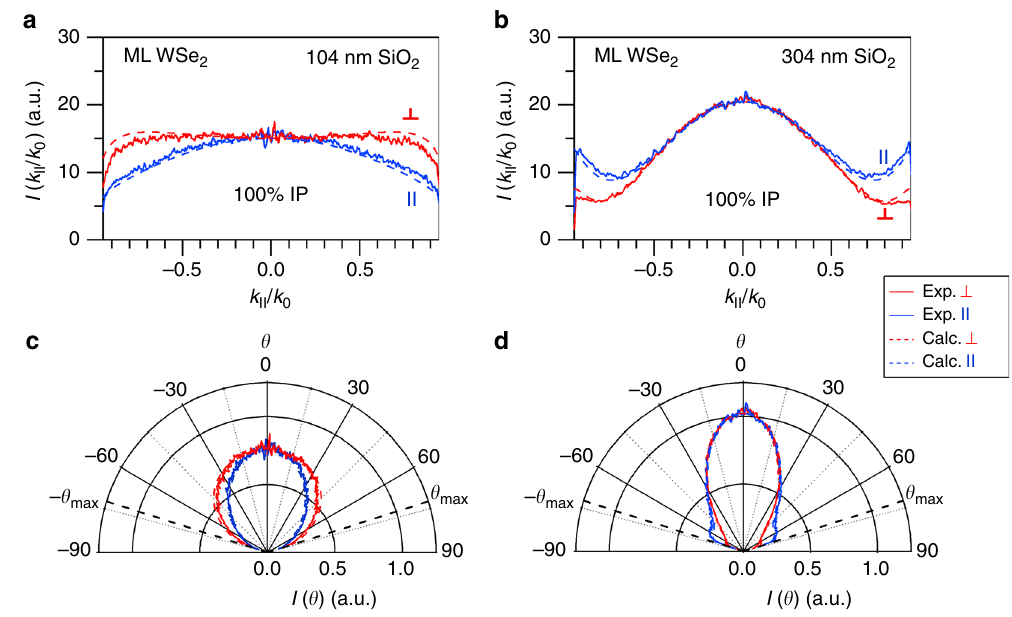
Fig. 3 Orientation of luminescent excitons in monolayer (ML) WSe 2 . a , b Experimental k -space emission pro fi les of ML WSe 2 fl akes deposited on top of SiO 2 /Si substrates with SiO 2 thicknesses of 104.0 ± 0.1 and 304.0 ± 0.1 nm, respectively, for directions parallel ( ∥ ) (blue solid lines) and perpendicular ( ⊥ ) (red solid lines) to the collection polariser. Dashed lines represent the result of a simultaneous fi t of the experimental k -space pro fi les to the analytical model described in Methods. c , d Measured and calculated far- fi eld emission patterns corresponding to the results shown in Fig. 3a, b as a function of the emission angle θ , respectively. The black dashed lines indicate the maximum collection angle ( θ max ) provided by the objective used in our experiments